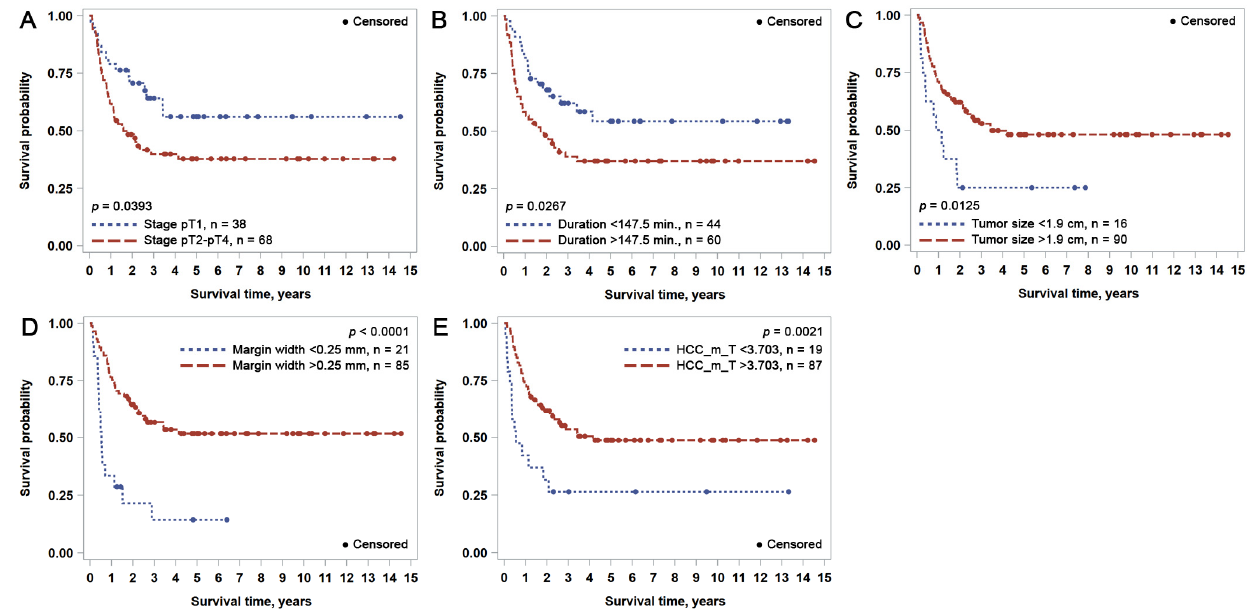
Figure 3. Kaplan-Meier recurrence-free survival (RFS) plots for independent prognostic indicators identified by multiple Cox regression analysis: ( A ) pT tumor stage; ( B ) duration of surgery; ( C ) tumor size; ( D ) tumor-free resection margin width; ( E ) mean CD8+ density in the epithelial aspect of tumor-stroma interface.